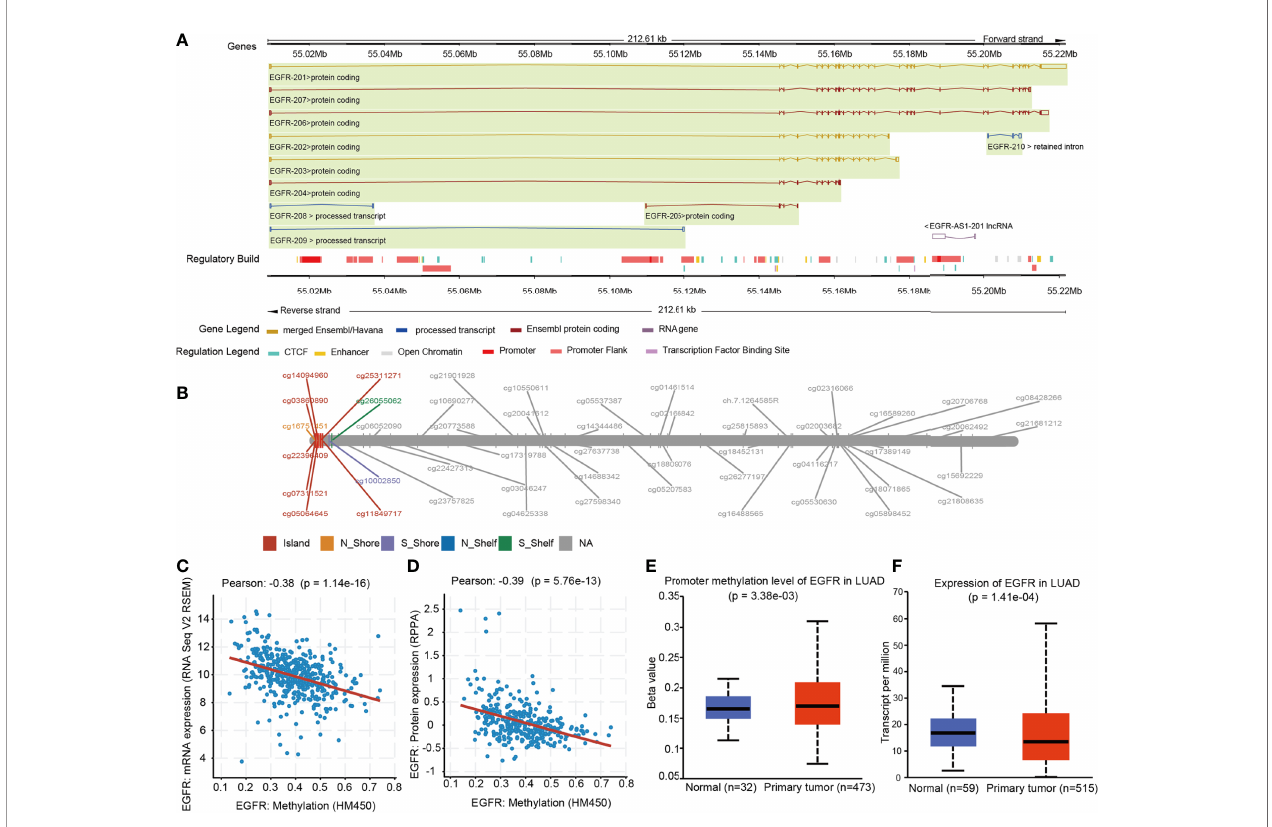
FIGURE 1 | EGFR Genomic structure, CpG site landscape, methylation level. (A) Schematic representation of the EGFR gene structure within the human hg19 genome sequence. (B) Overview of 49 analyzed methylation sites of EGFR. (C) Correlation analysis between DNA methylation and mRNA expression of EGFR in the TCGA LUAD cohort. (D) Correlation analysis between DNA methylation and protein expression of EGFR in the TCGA LUAD cohort. (E) Promoter methylation levels of EGFR on normal and LUAD tissues. (F) EGFR mRNA expression in normal and LUAD